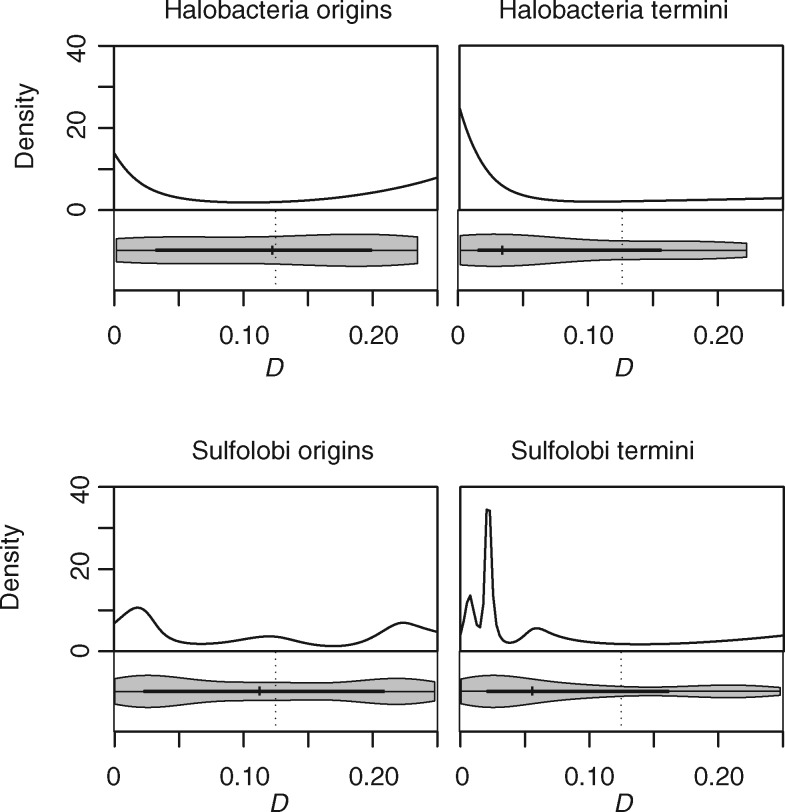
Distribution of D scores for ori- and ter-centered territories in Sulfolobus and Halobacteria.